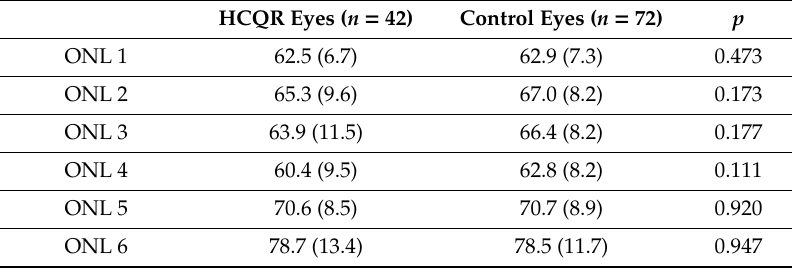
Table 2. Comparison of outer nuclear layer (ONL) between hydroxychloroquine retinopathy (HCQR) eyes and control eyes. Data for quantitative variables are shown as mean (standard deviation). Analysis was performed using the Mann–Whitney test. * p -value is <